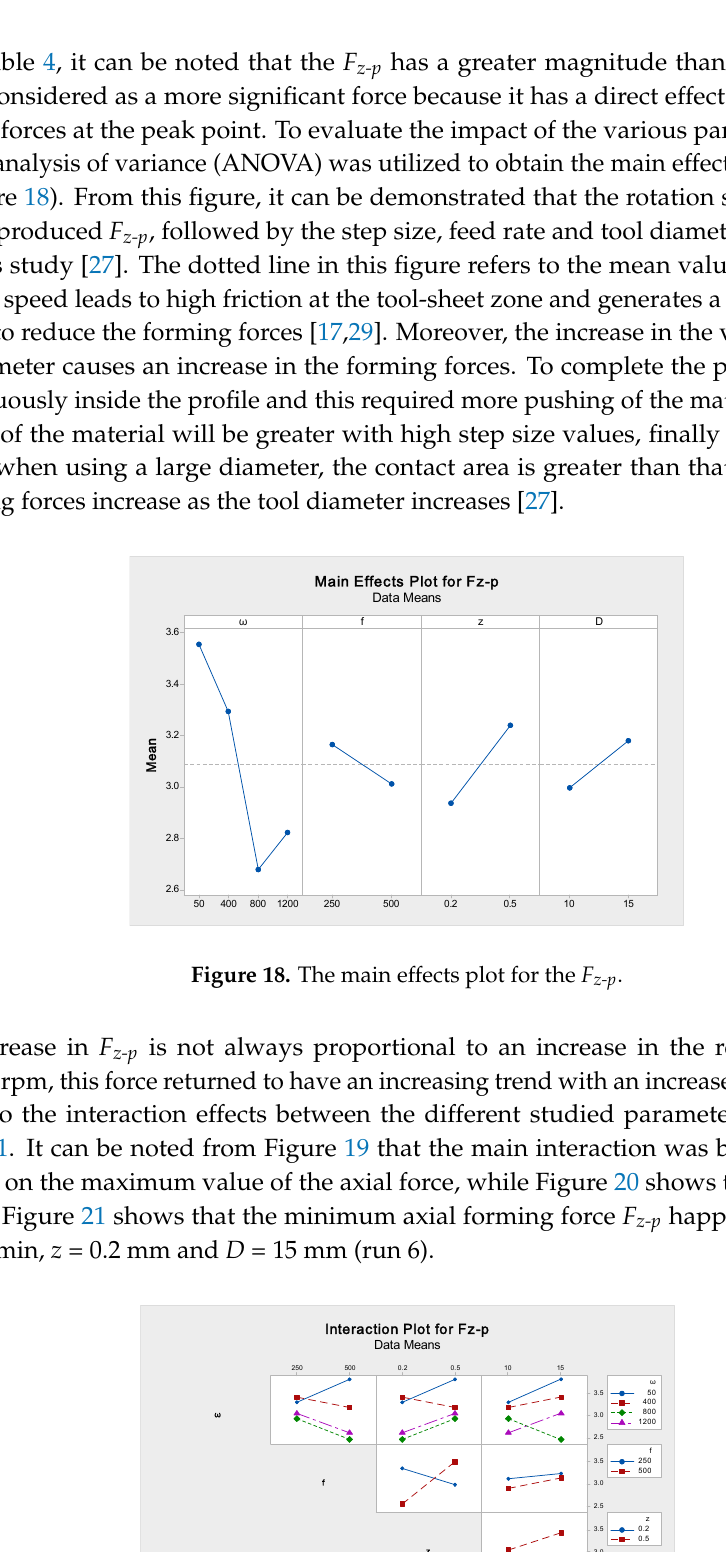
Figure 19. The interactions plot for the F z-p .